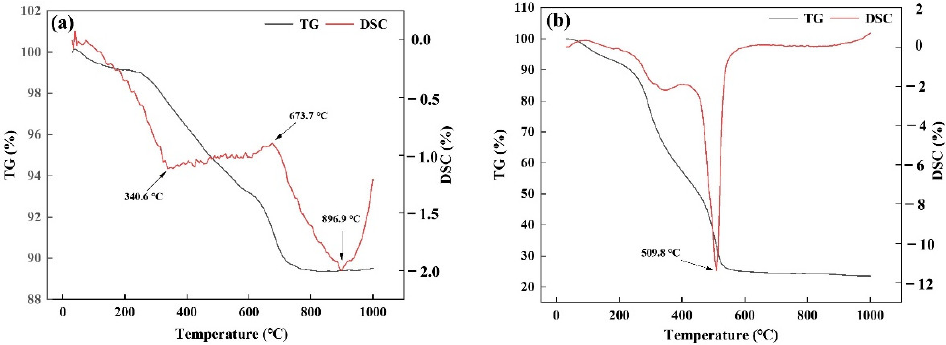
Figure 3. TG curves of sediment ( a ) and cyanobacterial powder ( b ) .